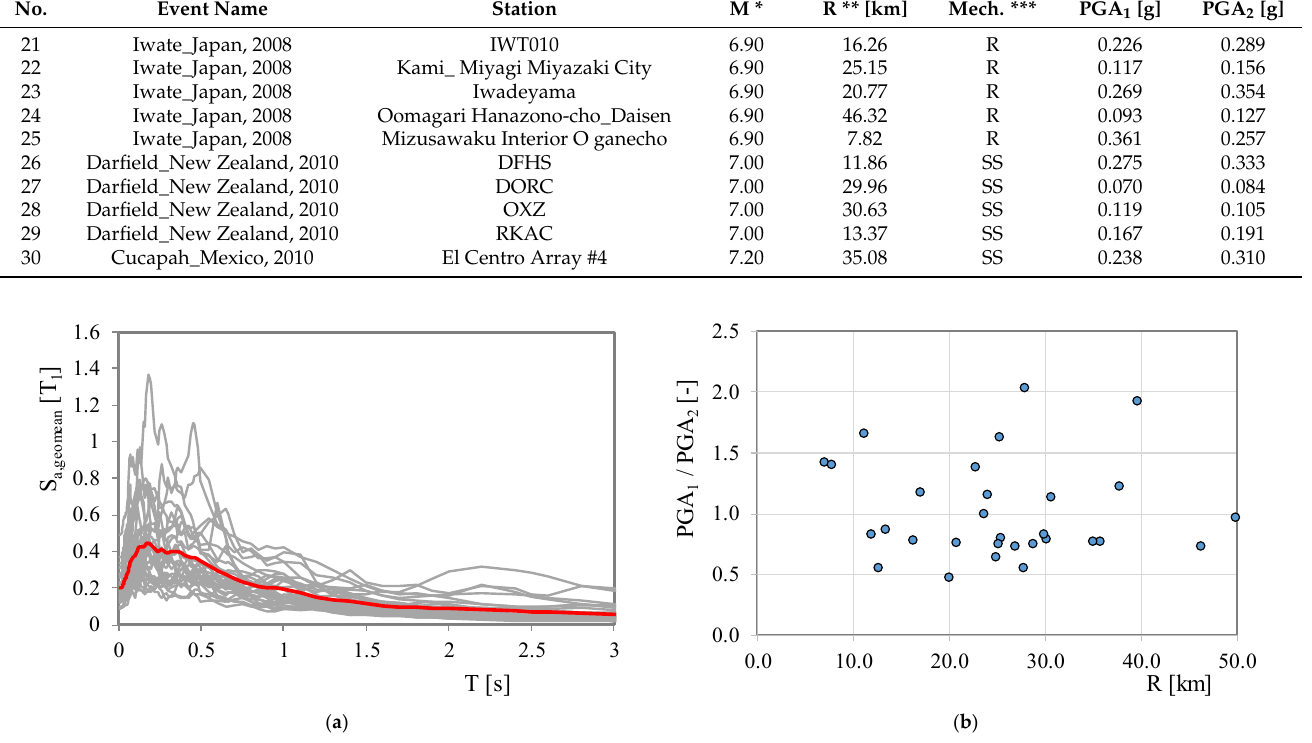
Figure 2. Main characteristics of the adopted accelerograms. ( a ) Elastic acceleration response spectra; ( b ) PGA 1 /PGA 2 Vs. R (distance to fault).